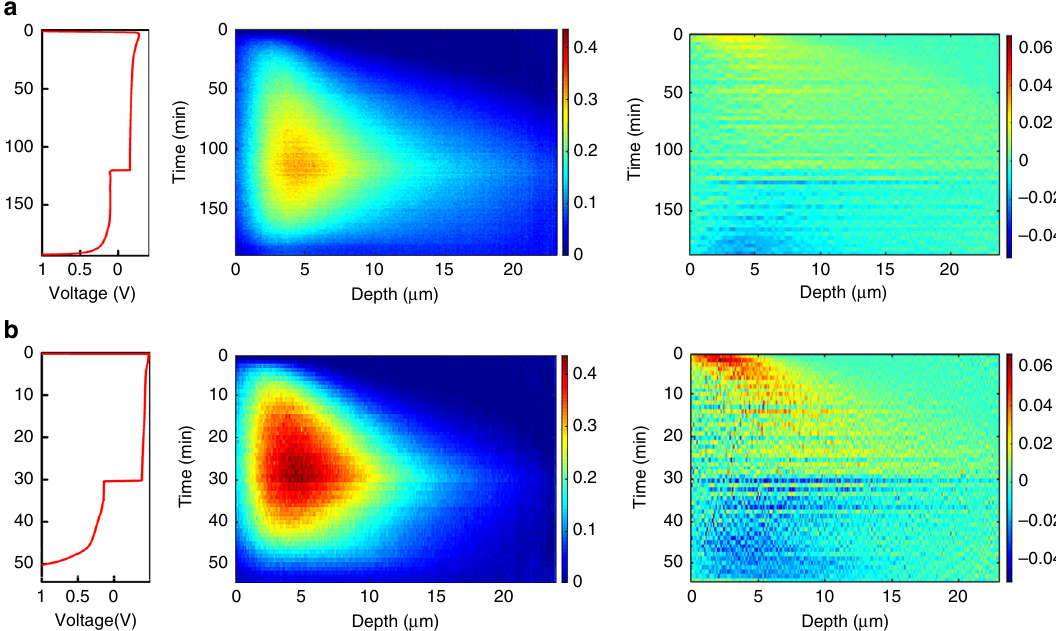
Fig. 3 Impact of the current density on the Li density distribution. a Operando NDP measurements of the fi rst plating and stripping cycle including the plating and striping activity at 0.5 mAh cm − 2 and b at 2 mAh cm − 2 . The depth is measured starting from the interface of the Cu current collector with the